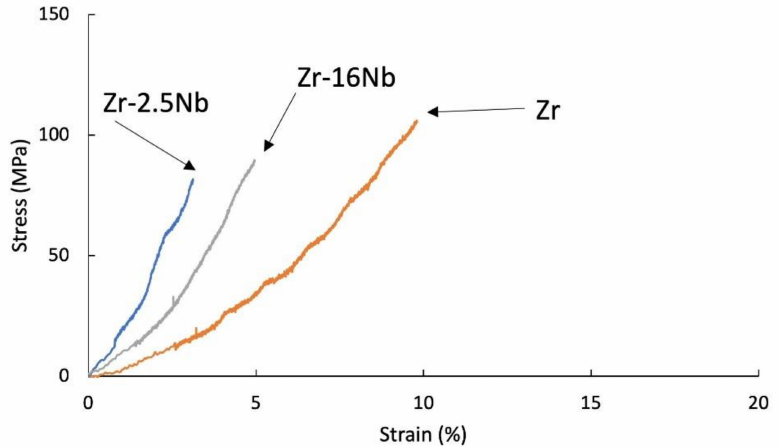
Figure 6. Tensile stress-strain curves of KOBO-extruded Zr-2.5 mass% Nb, Zr-16 mass% Nb and Zr materials; tests were carried at room temperature.